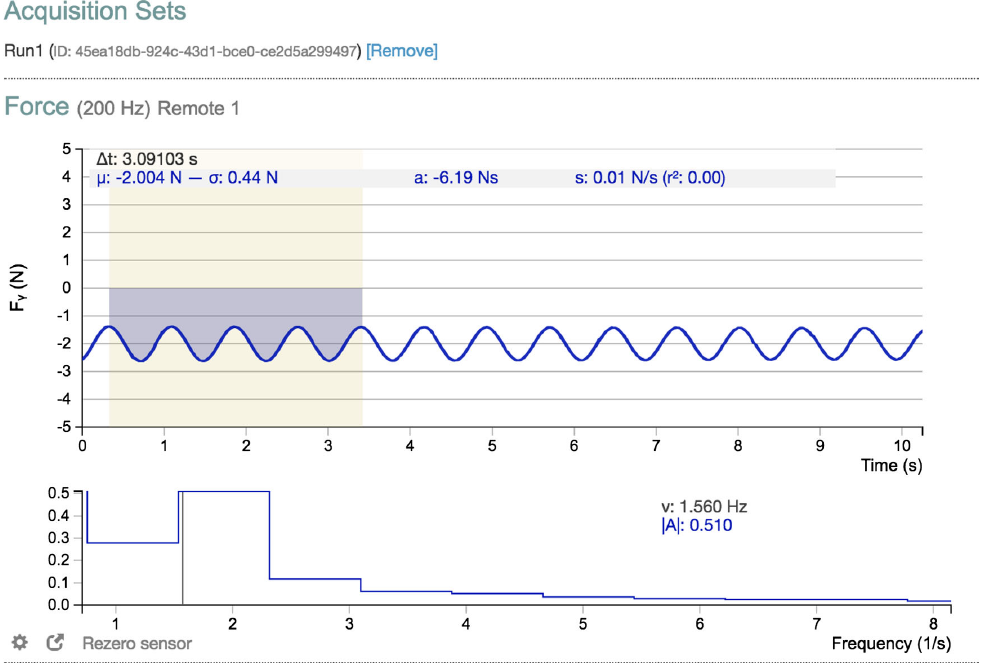
FIG. 2. Data collection sample for iOLab simple harmonic motion online